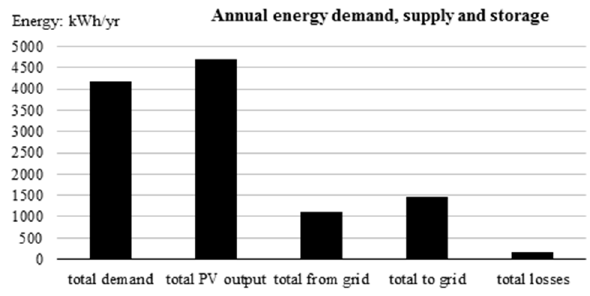
Figure 14. Summary of annual energy demand and supply. The total solar PV power includes the power used by the house, the surplus PV power and the losses.